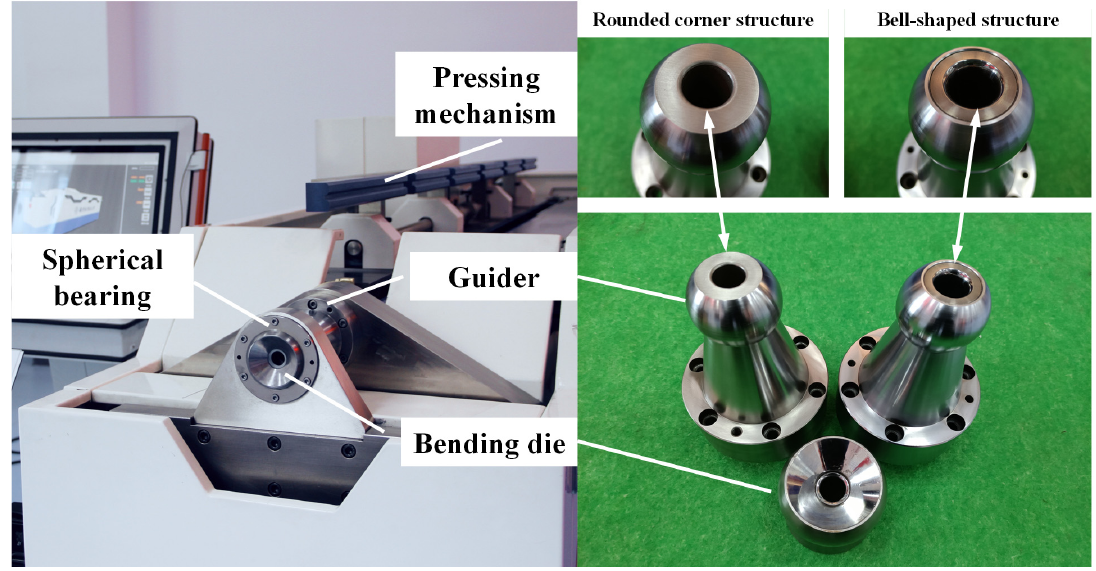
Figure 14. Three-axis free bending forming equipment and tools.